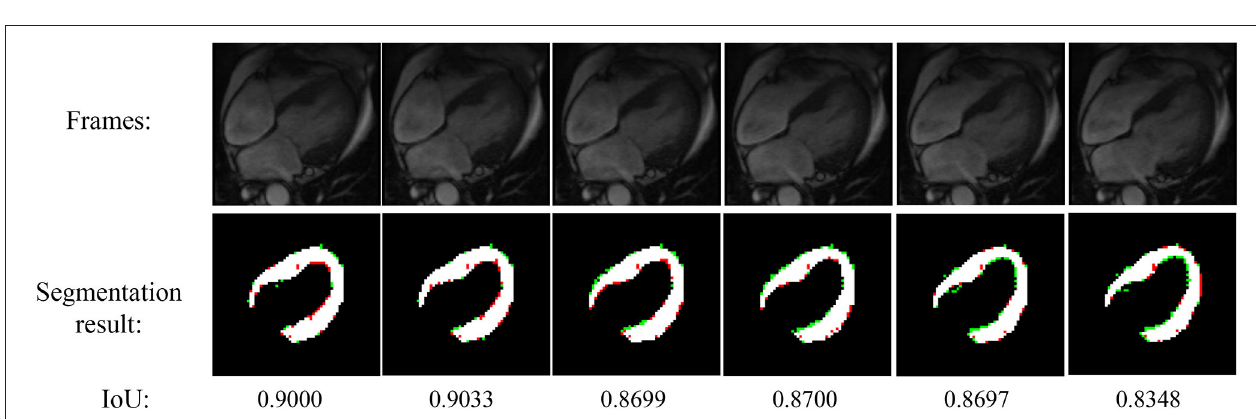
FIGURE 6 | IoU at difference training interactions. _f: IoU of the first frame; _m: mean IoU of the sequence. For illustration propose, the line in this figure is